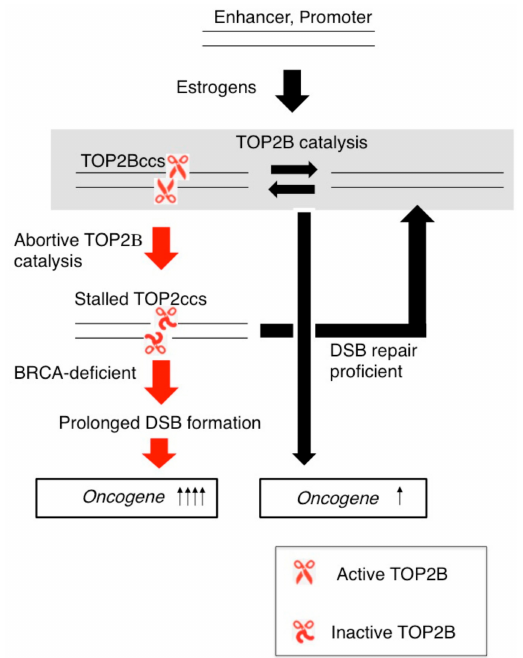
Figure 7. TOP2B catalysis and the formation of TOP2ccs a ff ect transcriptional responses to estrogens. TOP2B catalysis changes the three-dimensional structure of ER-target genes such as C-MYC and induces their transcription. DSB-repair-proficient normal cells are capable of very quickly repairing stalled TOP2Bccs. The loss of BRCA1 or BRCA2 protein causes accumulation of unrepaired DSBs, which may upregulate the transcriptional response of oncogenes to